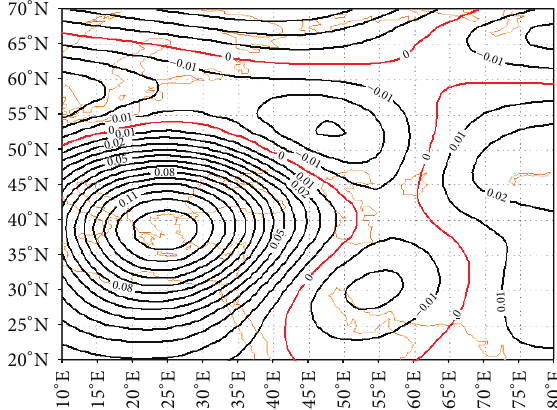
Figure 20: The third component of 500 HPa geopotential height level data.